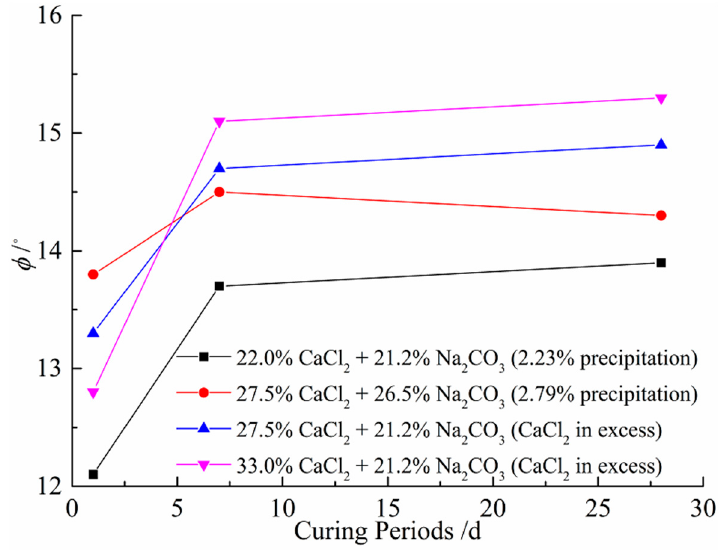
Figure 11. Variations of friction angles with different concentrations of solutions versus curing pe- riods.